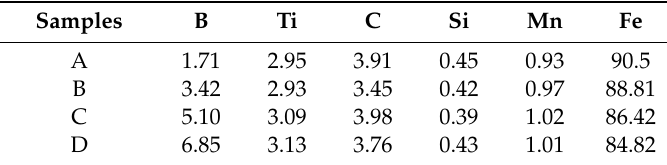
Table 2. Chemical composition (in wt. %) of various hardfacing